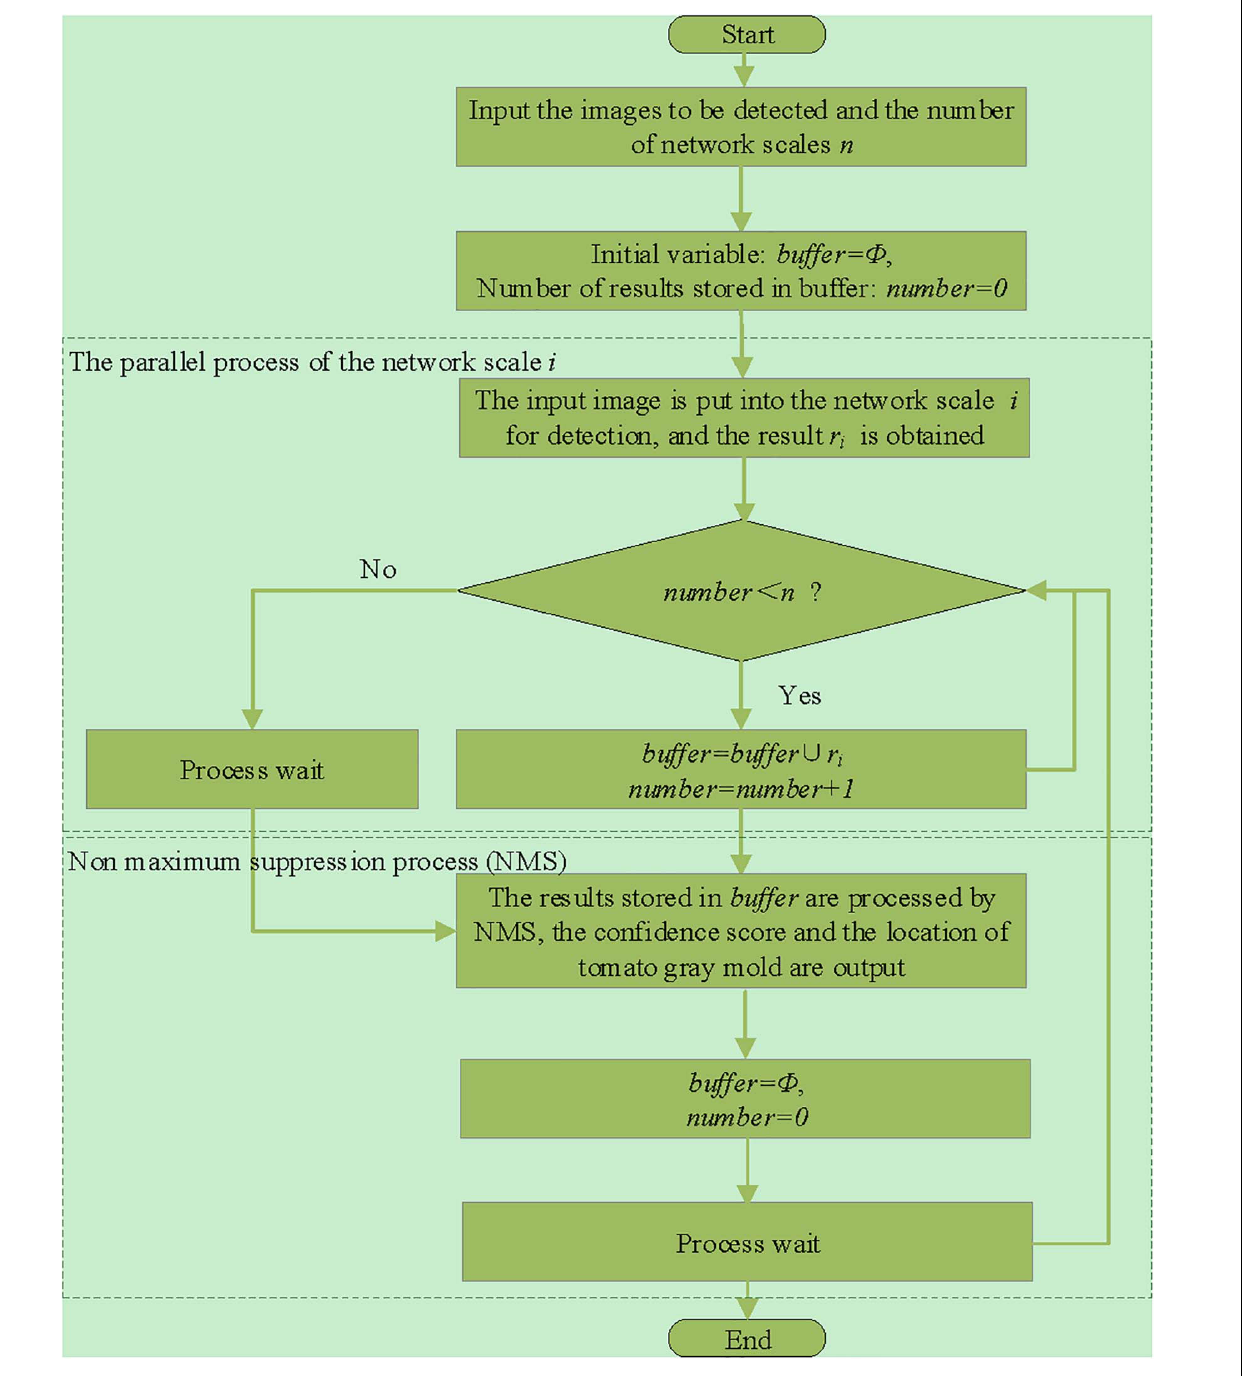
improving the detection